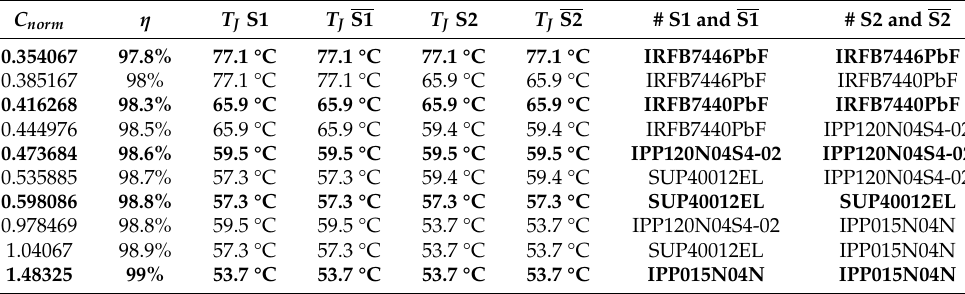
Table 6. Design details for PS with 800 W.